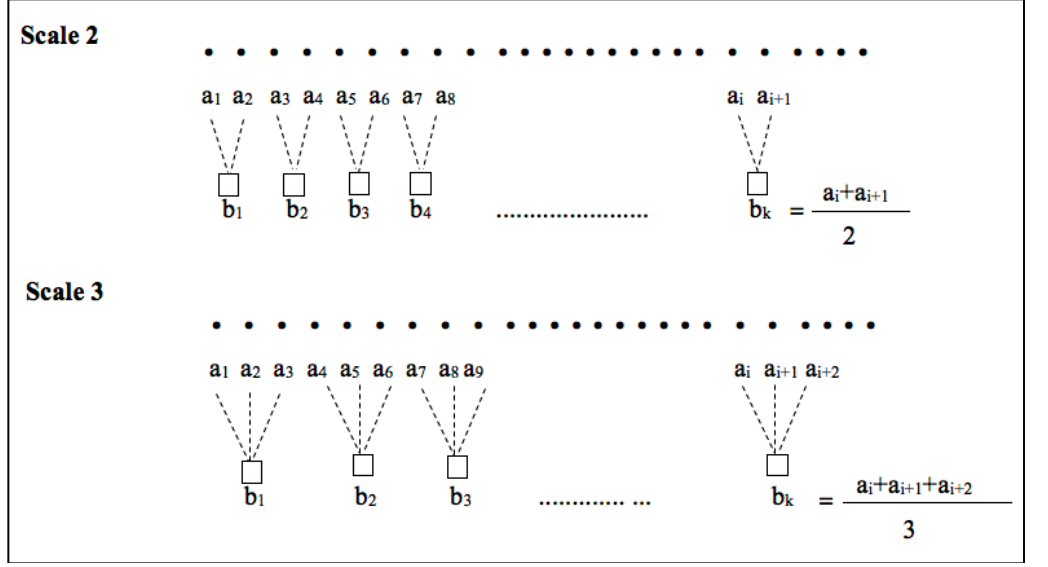
Figure 5. Illustration of the coarse-grained process in MMSE for scale factor 2 and scale factor